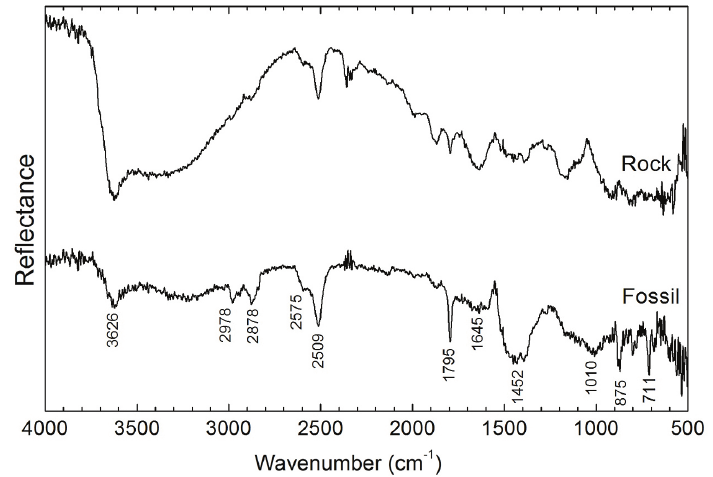
Figure 3. Diffuse reflectance infrared spectra of Corumbella werneri carapace and rock matrix. The positions of the absorption bands are indicated in the figure. Table 1. Comparison of IR reflectance bands for analyzed fossils and their rock matrices. Wavenumber (cm –1